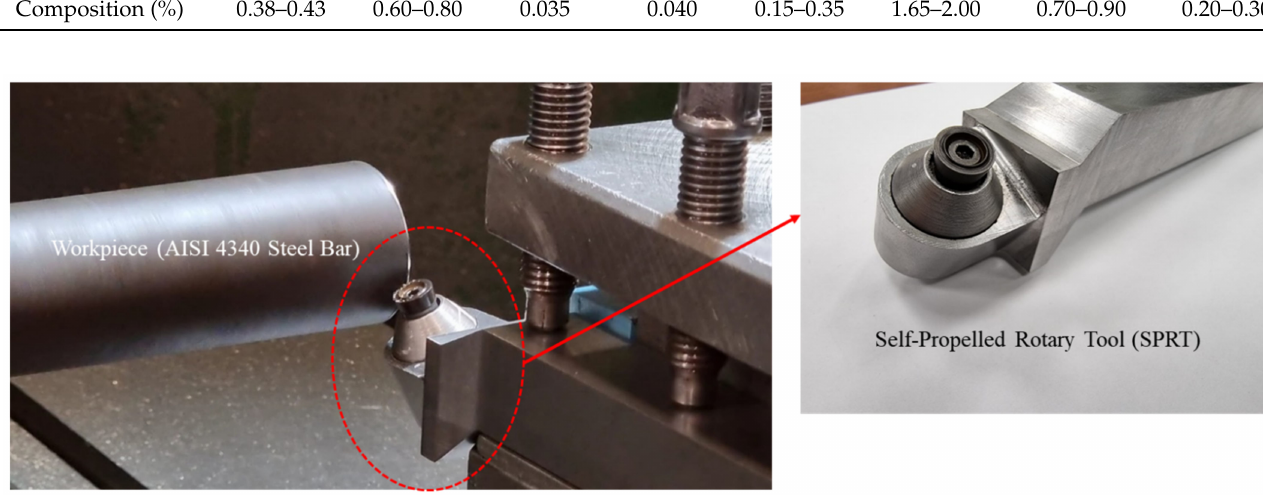
Figure 4. Experimental set up.